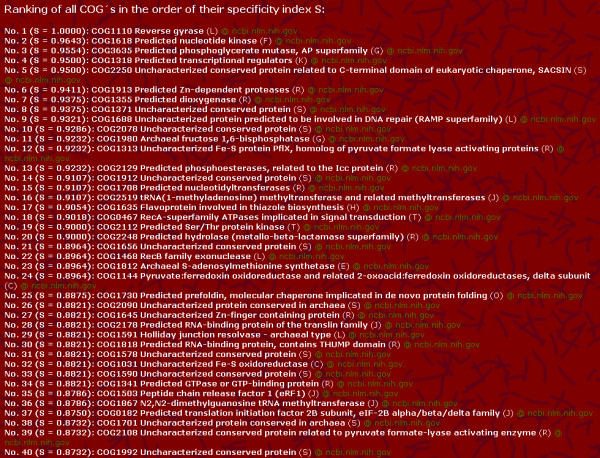
Partial screenshot of the COG-ranking